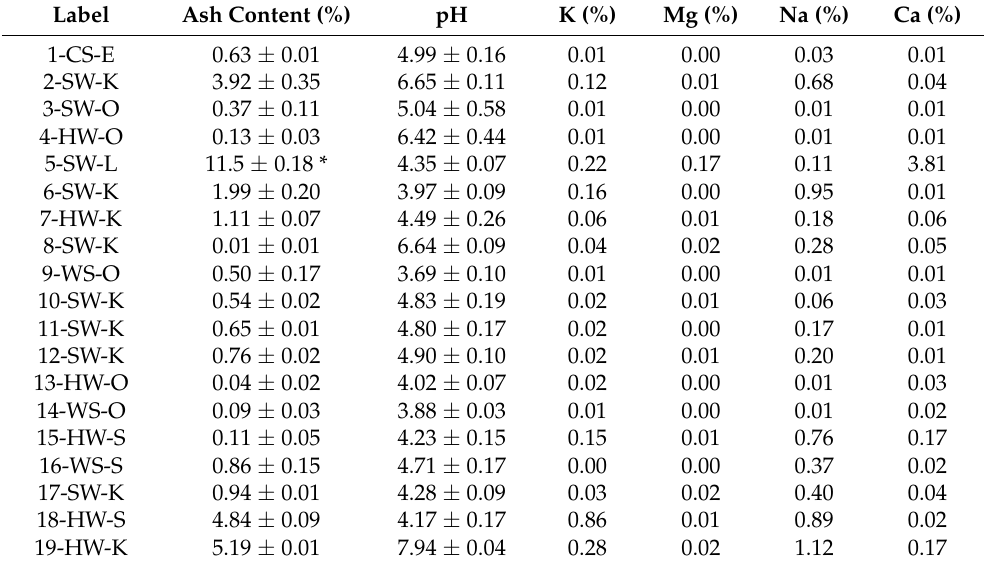
Table 1. Ash, pH, K, Mg, Na, and Ca content of lignin samples.